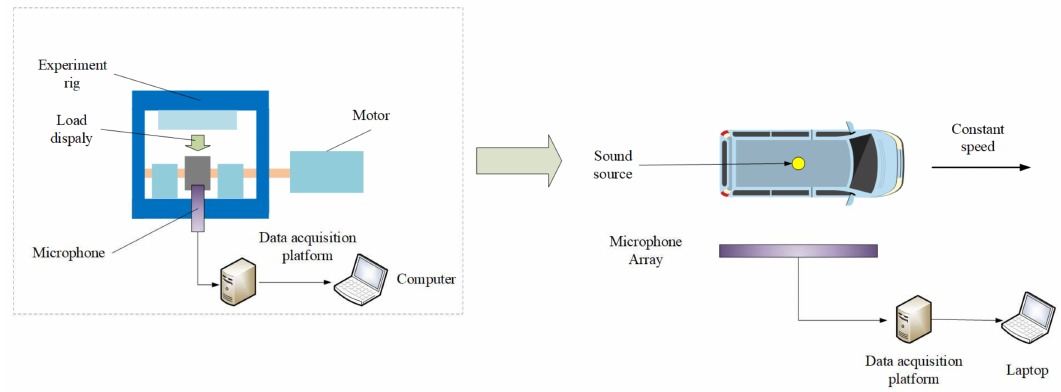
Figure 9. The Doppler signal acquisition